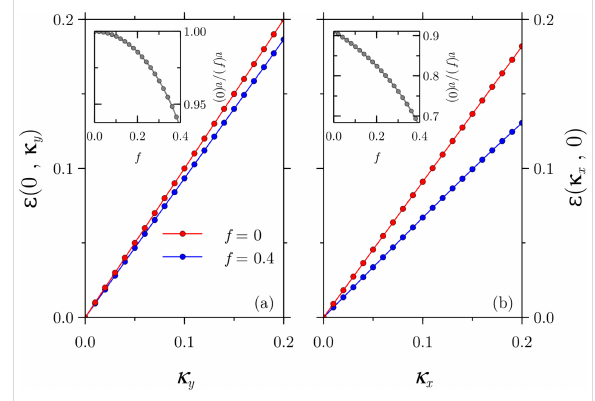
Figure 3: Comparison between exact and approximate results given by (a) Equation 21 and (b) Equation 22. In panel (a) the Fermi velocity along the x -direction, calculated as the slope of the dispersion relation, is substantially reduced and the agreement between the exact and ap- proximate results is noteworthy up to b ≤ 0.2. In panel (b), the Landau level splitting in the x -direction is very well predicted even for b = 0.5, as shown for the first level.